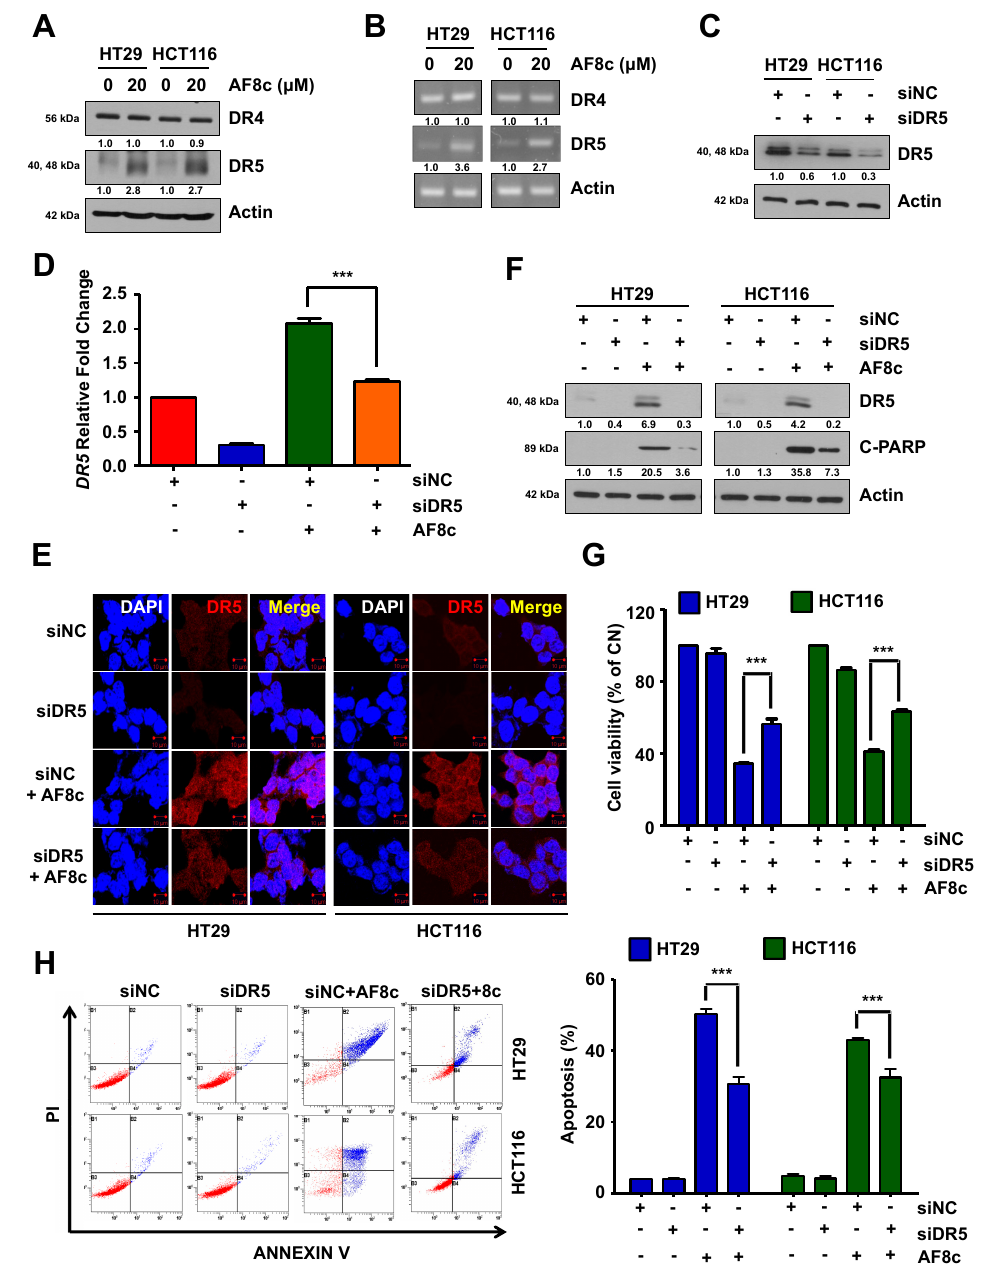
Figure 2. DR5 activation mediates AF8c-induced apoptosis: ( A ) the cells were incubated with AF8c for 24 h and subjected to immunoblotting using antibodies against DR4 and DR5; ( B ) DR4 and DR5 mRNA expression levels were analyzed by qRT-PCR; ( C ) after transfection with siRNAs for the negative control (siNC) or DR5 (siDR5), HT29 (left) and HCT116 (right) cells were analyzed using immunoblotting using antibodies against DR5 and actin; ( D – H ) after transfection with siNC or siDR5, cells were treated with or without 20 μ M AF8c. mRNA levels ( D ) and fluorescence intensity ( E ) were determined using qRT-PCR and immunofluorescence (scale bars, 10 μ m). Cell viability and apoptosis were assayed by immunoblotting ( F ), WST-1 analysis ( G ), and flow cytometry ( H ). ***, p < 0.001 .